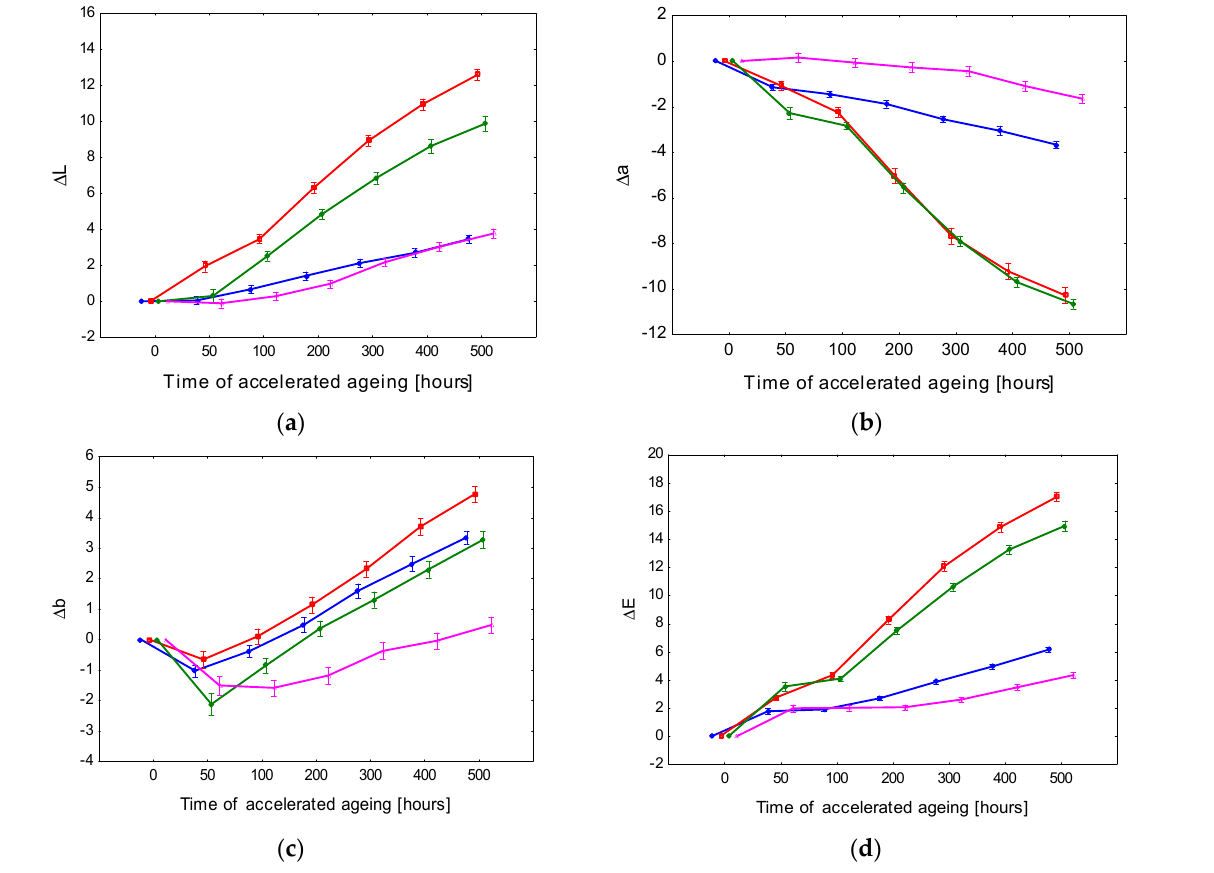
Figure 2. Accelerated-aging-induced differences in colour coordinates ( a ) Δ L* , ( b ) Δ a* , and ( c ) Δ b* , and the total colour difference ( d ) Δ E* of spruce wood surfaces finished with polyurethane lacquers on surfaces with pigment mordants.